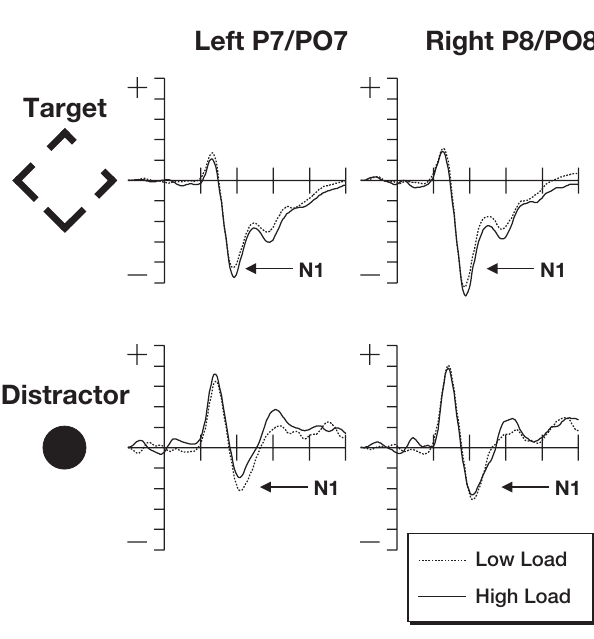
Figure 3. The N1 components from this study. Note that the increased perceptual load results in larger N1 responses to target stimuli, but that there is a decrease to distractor stimuli. The top row of plots shows ERPs to the tar- get stimuli where the participant was expected to make a gap judgment. The lower row shows ERPs to the irrelevant but salient central distractor stimuli. The horizontal axis shows time, beginning 100 ms prior to stimulus onset and continuing until 500 ms after onset, while the vertical axis shows the voltage (with a range from + 5 to − 5 µV). The solid line represents the ERP during periods of high perceptual load while the dotted line shows responses during sequences of low perceptual load.